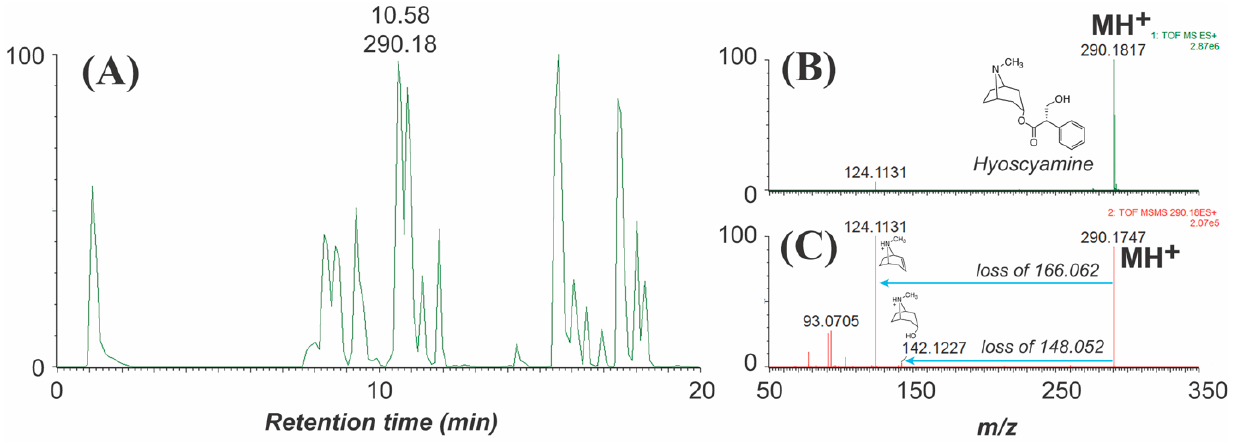
Figure 3. HPLC/ESI-MS base peak intensity chromatogram of a methanol-water extract of three-week-old D. metel root (left) using a C 18 LC column on a Waters Xevo G2-XS QToF high-resolution mass spectrometer. The analysis was performed using data-dependent MS/MS in positive-ion mode. ( A ) Survey scan base peak intensity chromatogram. ( B ) The survey scan spectrum for hyoscyamine (retention time 10.58 min). ( C ) MS/MS product ion spectrum for m/z 290 for hyoscyamine shows characteristic monosubstituted tropane alkaloid fragment ions at m/z 142 and 124.